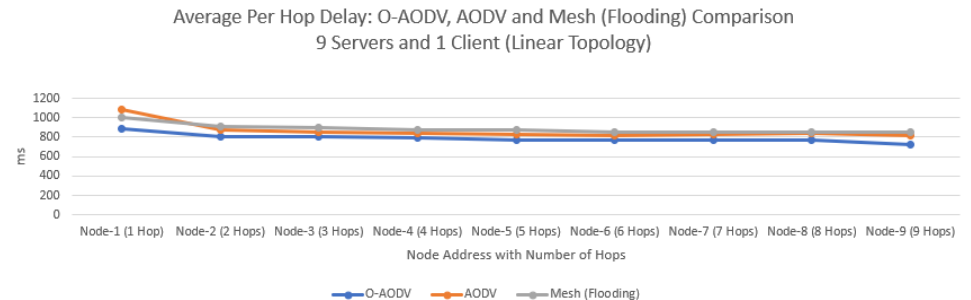
Figure 9. Average per-hop delay: O-AODV, AODV, and mesh (flooding) comparison.